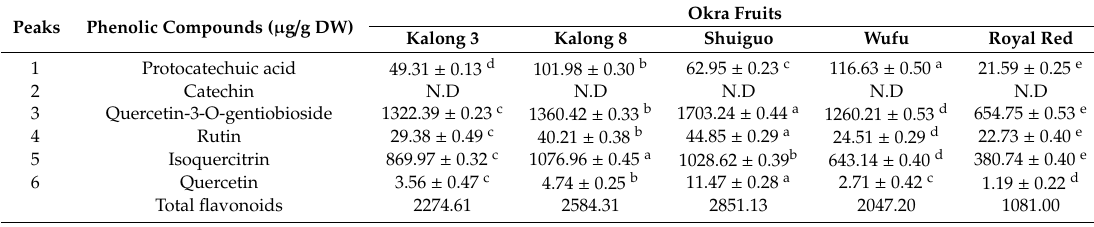
Table 2. Contents of individual phenolic compounds in di ff erent cultivars of okra fruits. Peaks Phenolic Compounds ( µ g / g